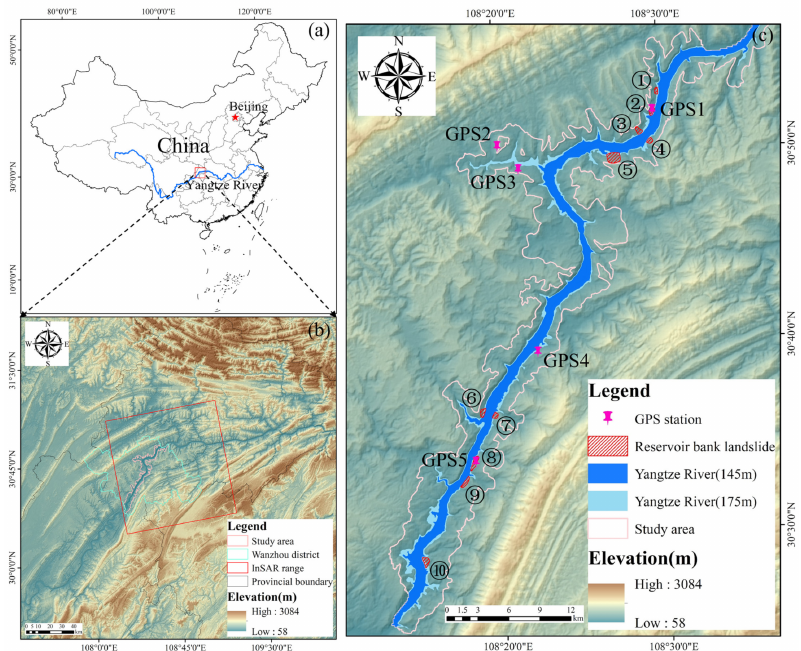
Figure 1. ( a ) Location of the study area; ( b ) Location of study area and InSAR range; and ( c ) Locations of 10 reservoir bank landslides in the study area ( 1 (cid:13) Laotangfang landslide; 2 (cid:13) Sharentian landslide; 3 (cid:13) Sifangbei landslide; 4 (cid:13) Xiangjiaping landslide; 5 (cid:13) Tangjiao landslide; 6 (cid:13) Rangduchangbei land- slide; 7 (cid:13) Datangbang landslide; 8 (cid:13) Jinjinzi landslide; 9 (cid:13) Wuchiba landslide; and 10 (cid:13) Zhangjiacitang